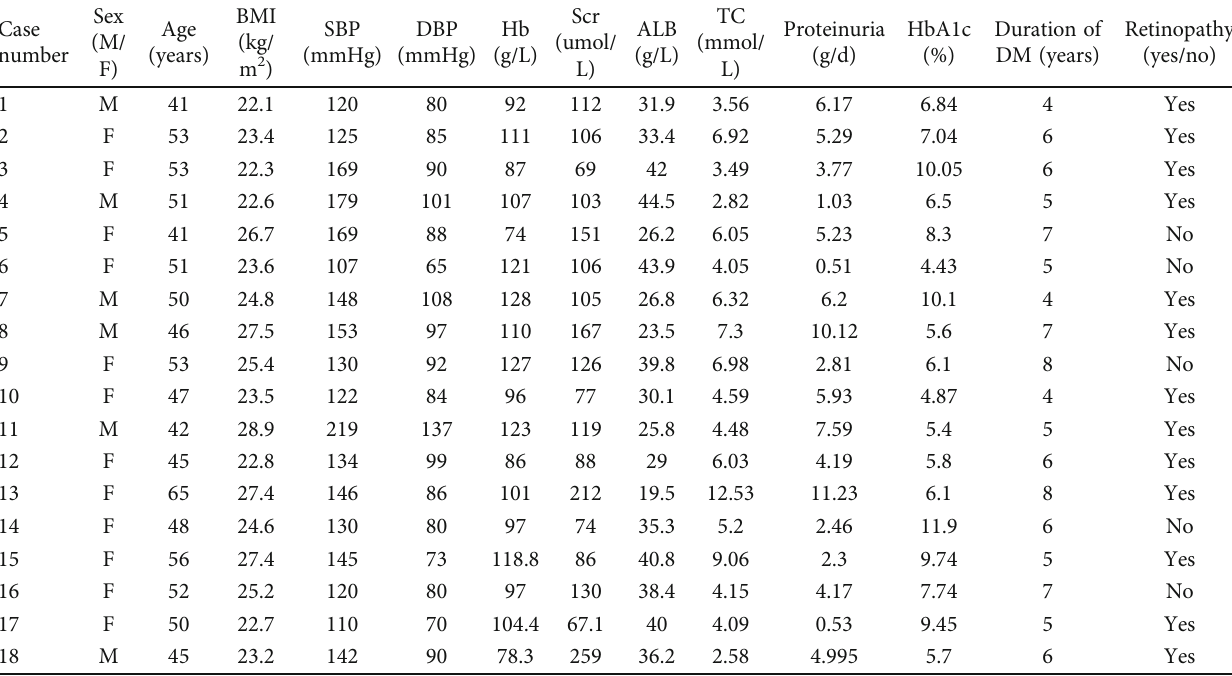
Table 1: Clinical characteristics of DN patients.